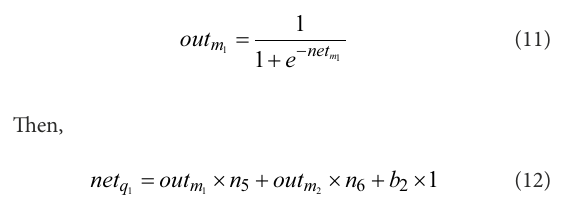
FIGURE 3 Basic neuron model